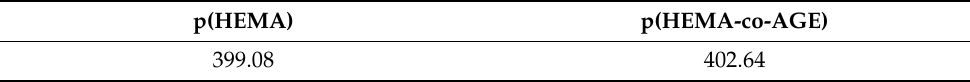
Table 2. N(1S) XPS spectra analysis of p(HEMA) and